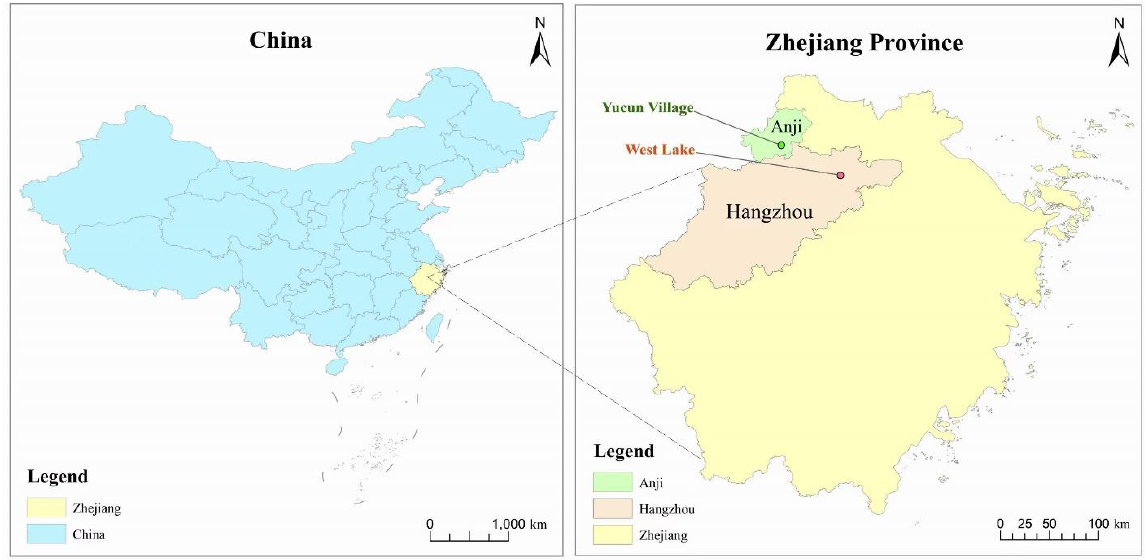
Figure 2. Geographical locations of Anji and Hangzhou.